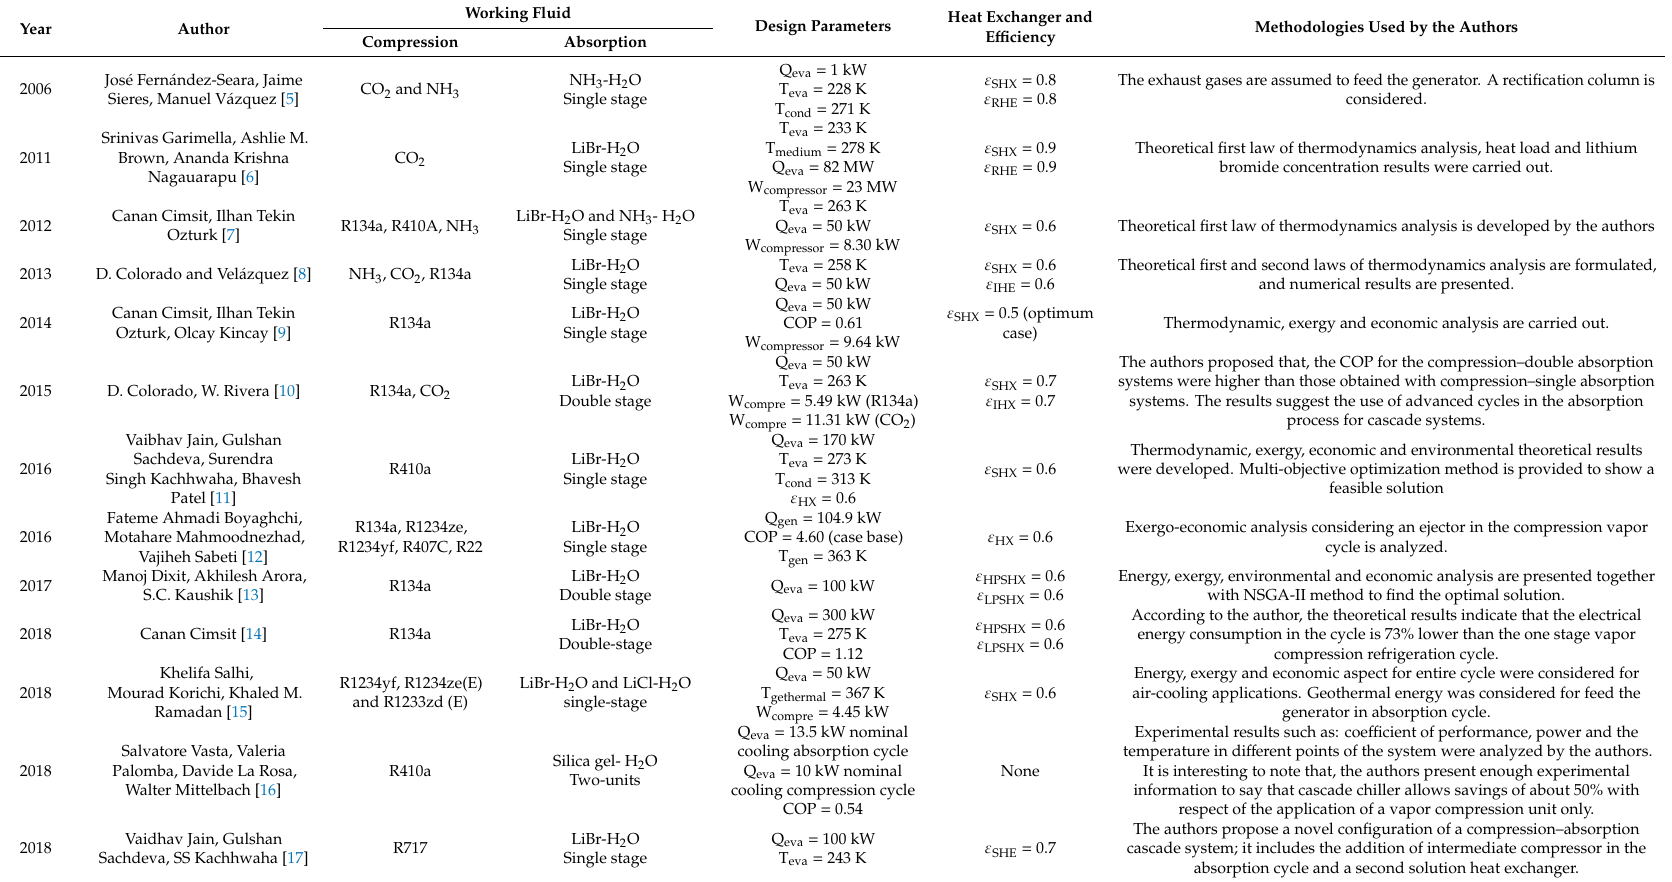
Table 1. A compressive review of cascade refrigeration cycles with an emphasis on used